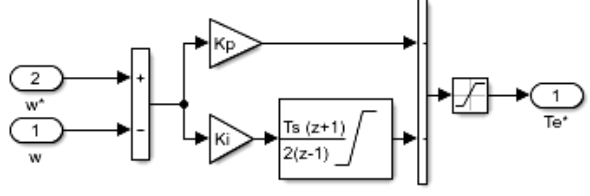
Figure 2. Simulink model P–I speed controller with torque